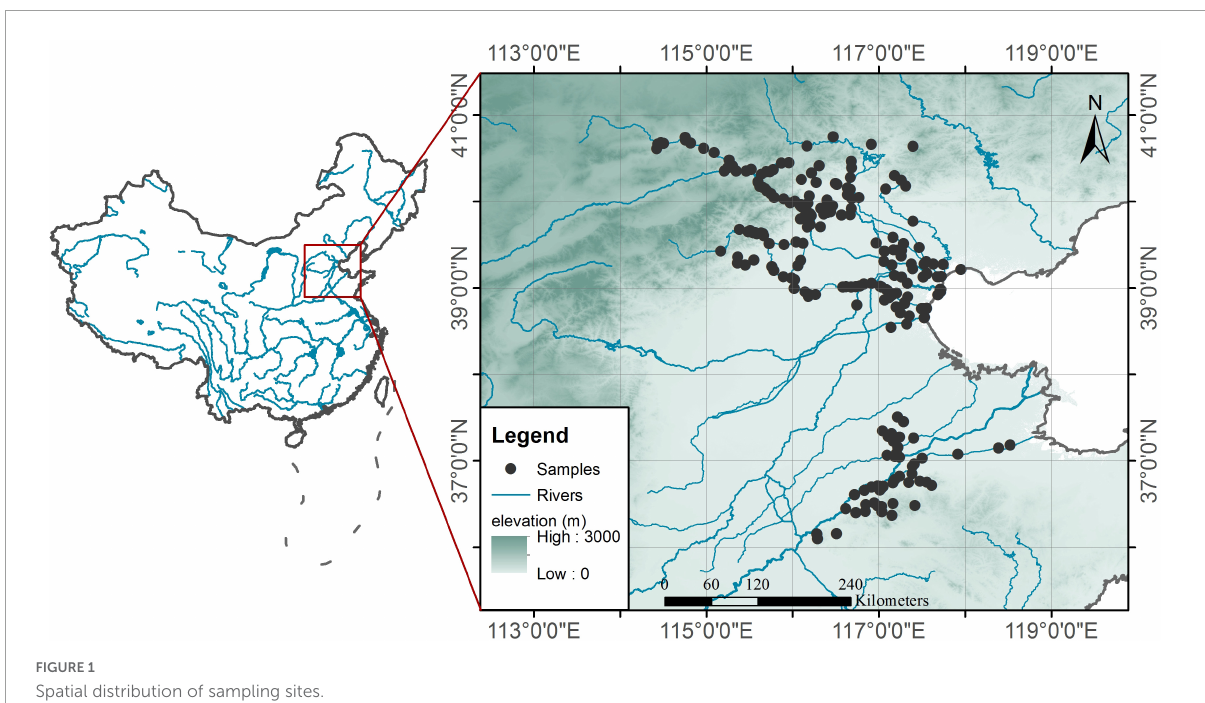
FIGURE1 Spatial distribution of sampling